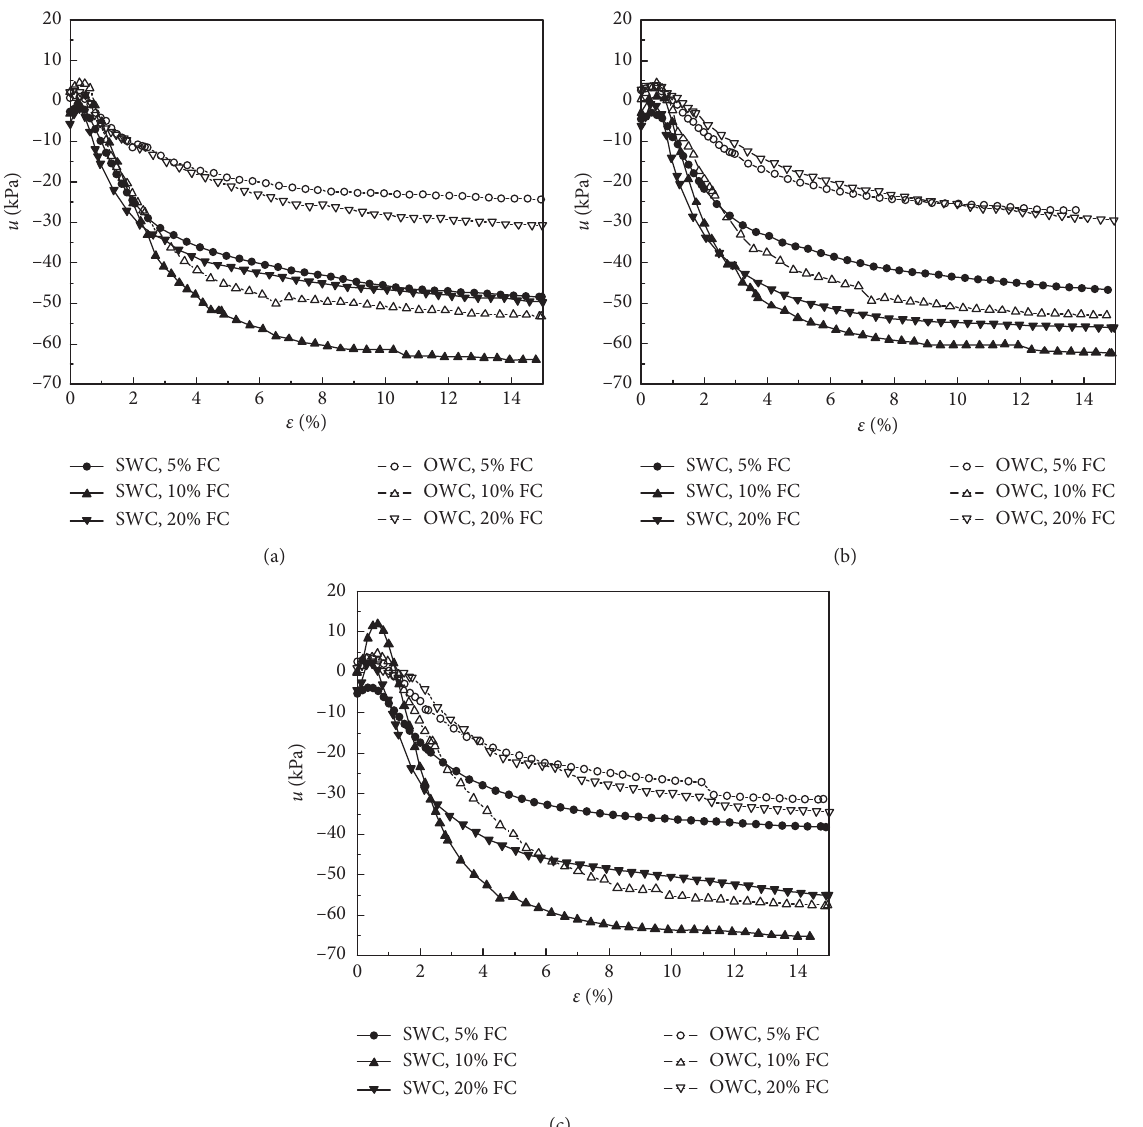
Figure 8: The evolvement of pore pressure against axial strain for graded gravels under the confining pressure of (a) 20kPa, (b) 40 kPa, and (c)